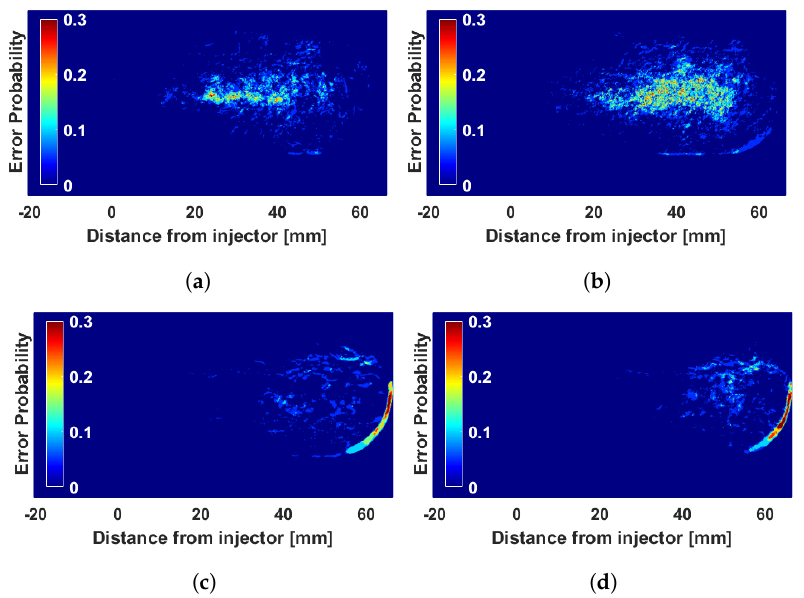
Figure 12. Error zone probability maps for non-physical solutions. t = 2900 µ s. ( a ) High dynamic range and high soot; ( b ) low dynamic range and high soot; ( c ) high dynamic range and low soot; ( d ) low dynamic range and low soot.